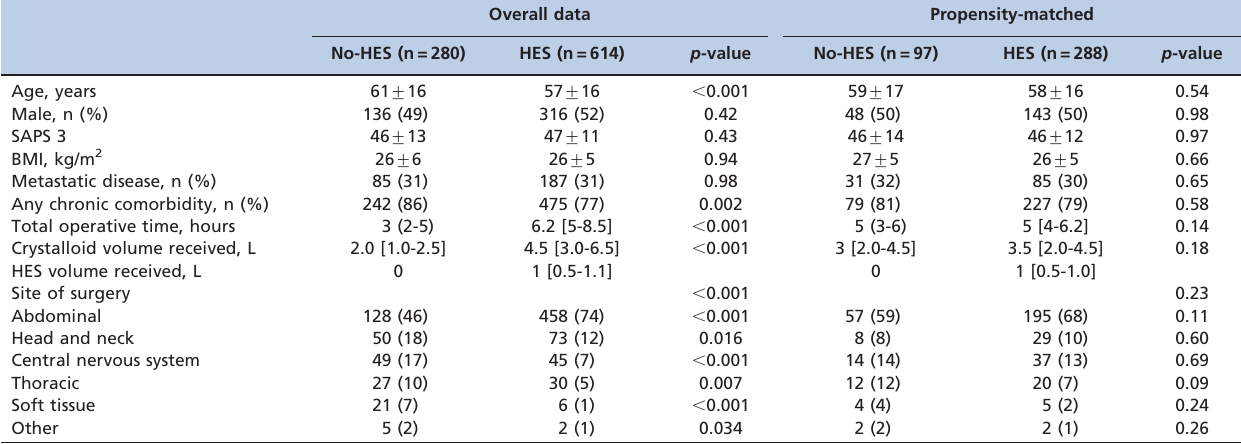
Table 1 - Baseline characteristics of the patients that received hydroxyethyl starch (HES group) and crystalloid during major oncologic